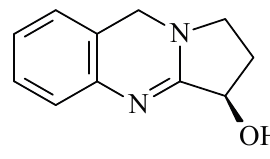
Figure 14. Peganine.